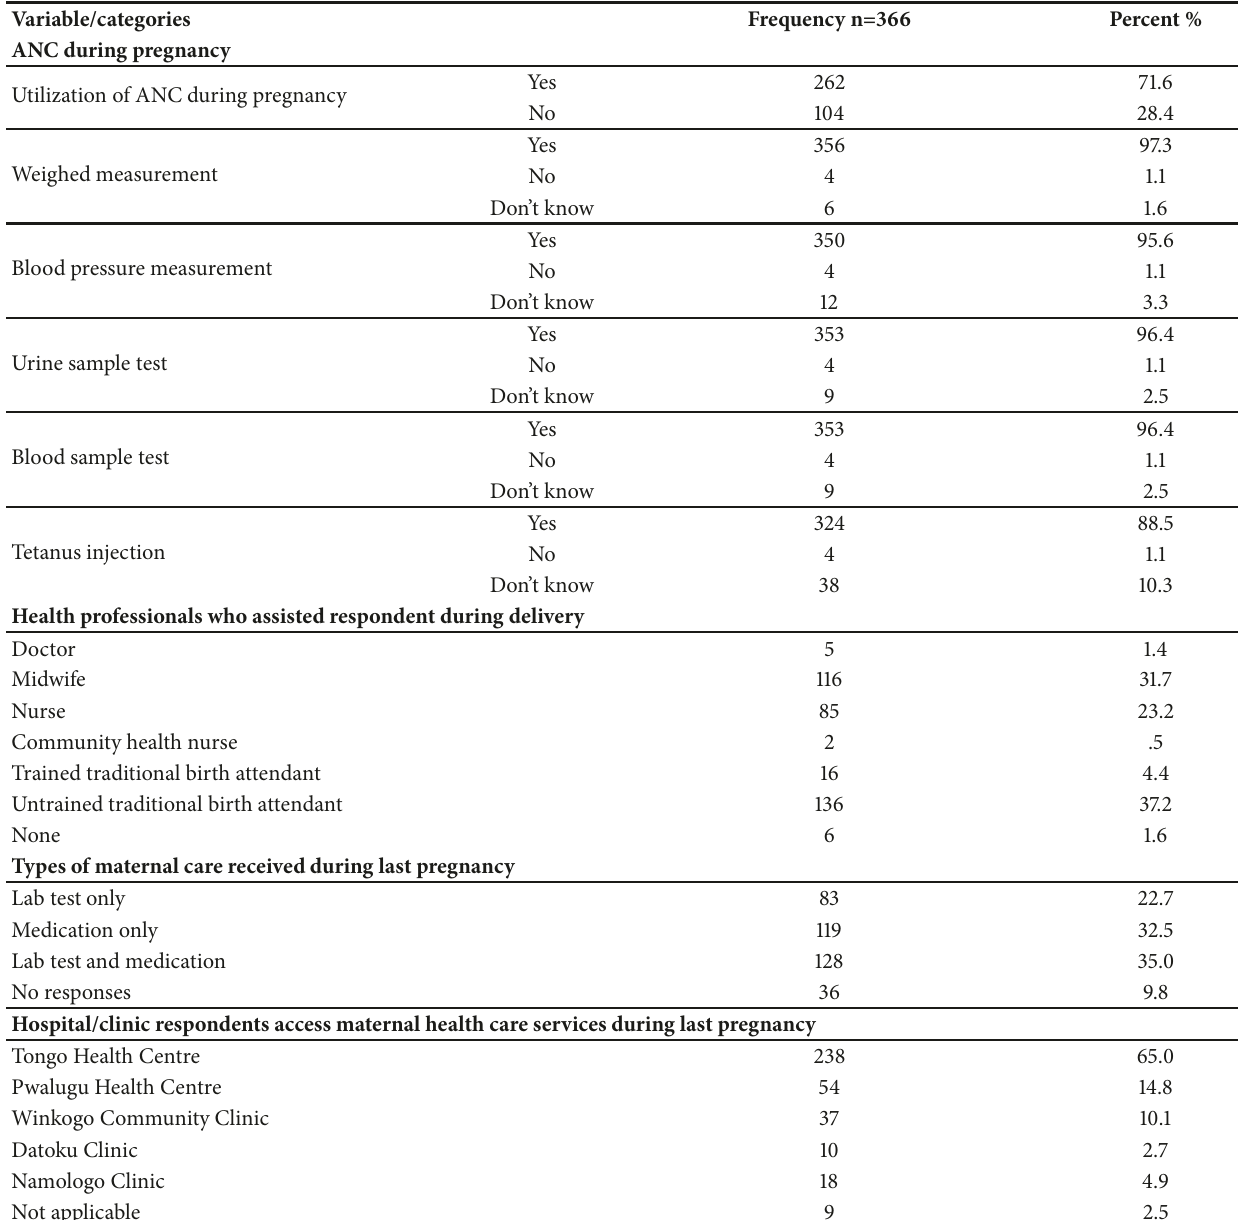
Table 4: Sources and type of maternal health care services received by